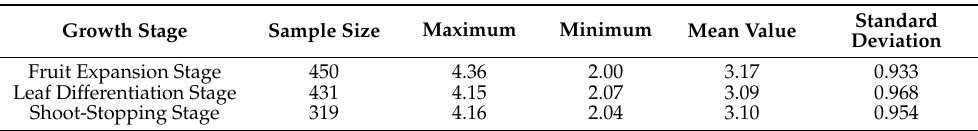
Table 4. Basic statistics of the ground-truth LAI measurements for the studied apple trees during three growth stages.